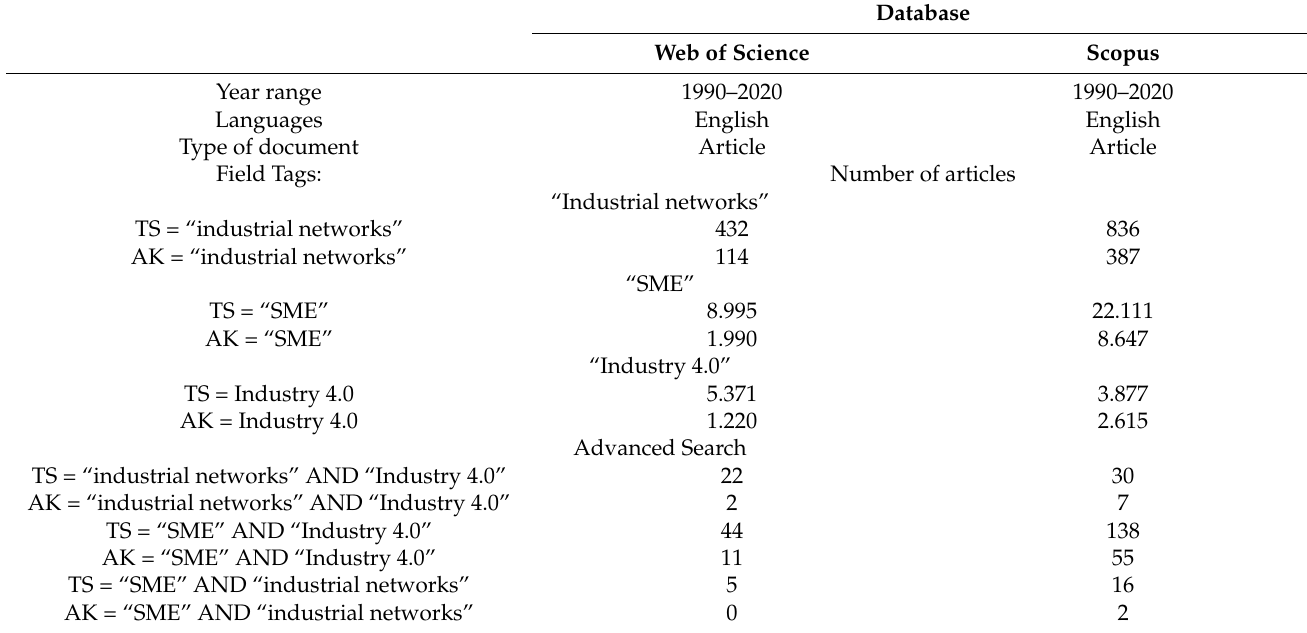
Table 1. Detailed search data from Web of Science and Scopus